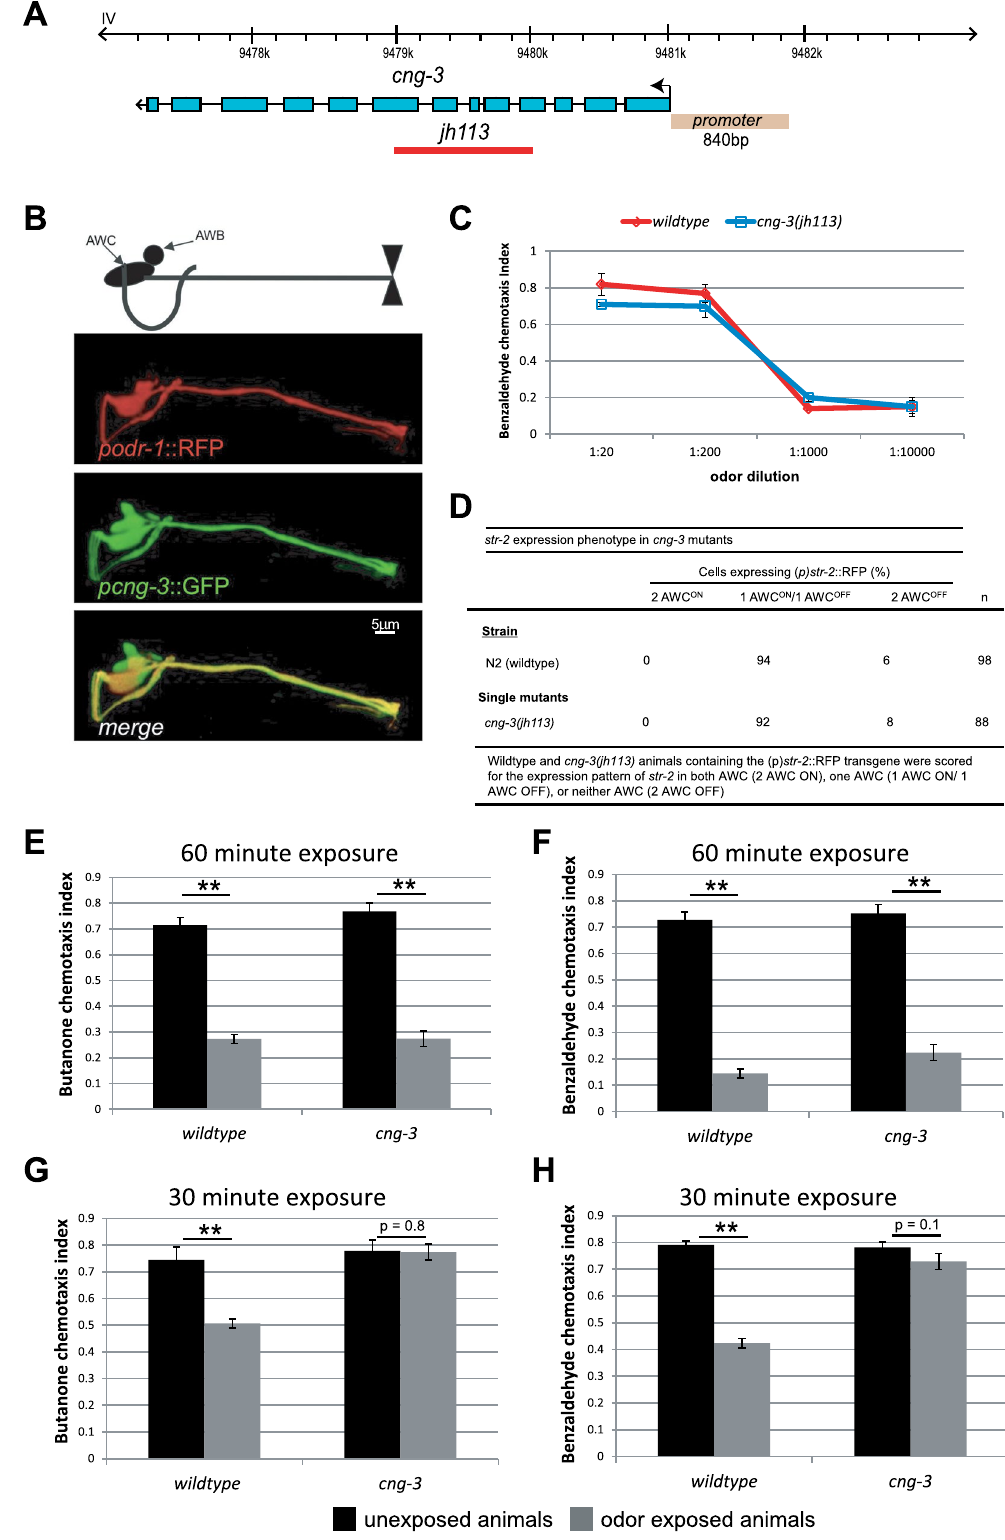
Figure 1. The CNG channel subunit CNG-3 is required for short-term adaptation responses in the primary sensory neuron pair AWC. ( A ) Gene structure of cng-3 on chromosome IV indicating the position of the deletion in jh113 12 . 840 bp upstream of the start site for cng-3 was used to generate a transcriptional reporter for cng-3 . ( B ) PCR fusion 43 was used to fuse the promoter region of cng-3 to GFP. In the bottom panel, an overlay of the GFP and RFP expression patterns depicts the co-expression of GFP and RFP in the AWC neuron. ( C ) Chemotaxis assays were performed for wildtype and cng-3(jh113) animals to various concentrations